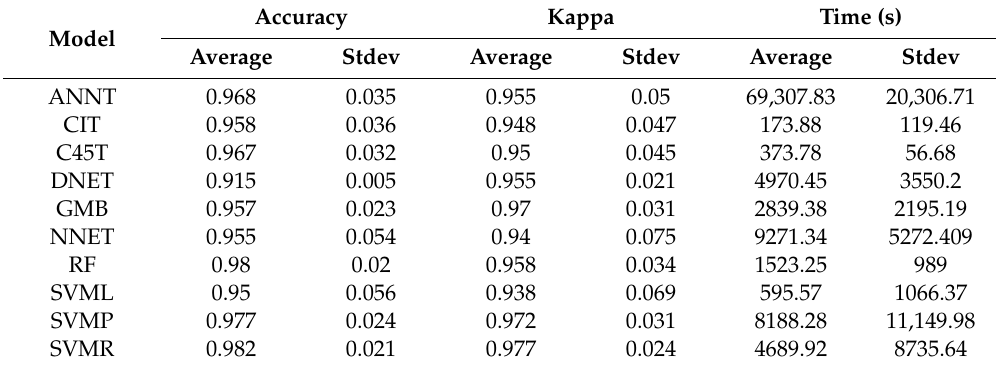
Table 3. Average values of accuracy, kappa and processing times.